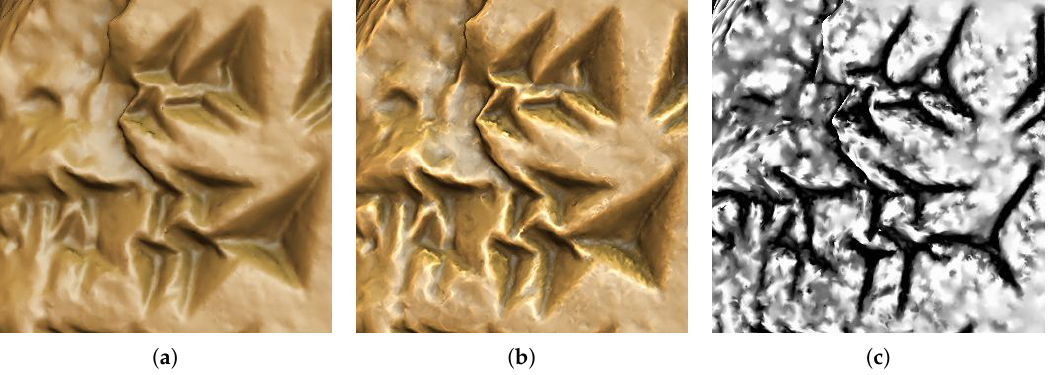
Figure 5. Section of cuneiform fragment E971 without ( a ) and with radiance scaling ( b ) and a stylized rendering ( c ) of the same section in autography